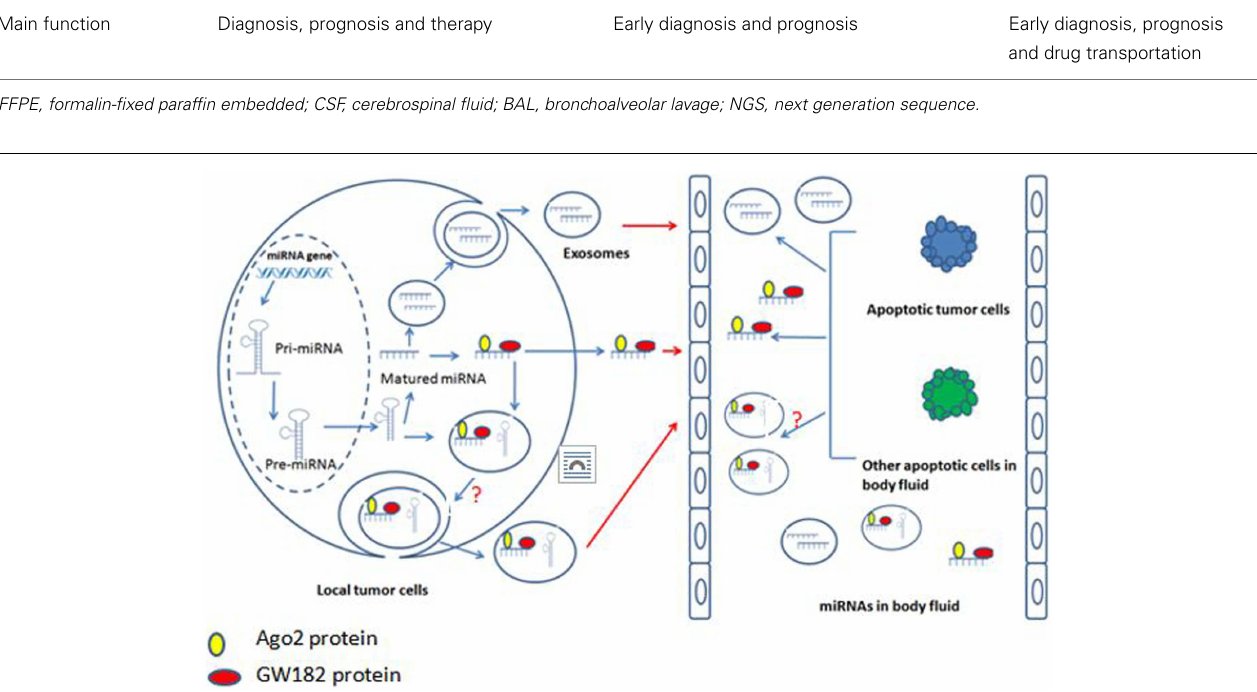
Frontiers in Oncology | Cancer